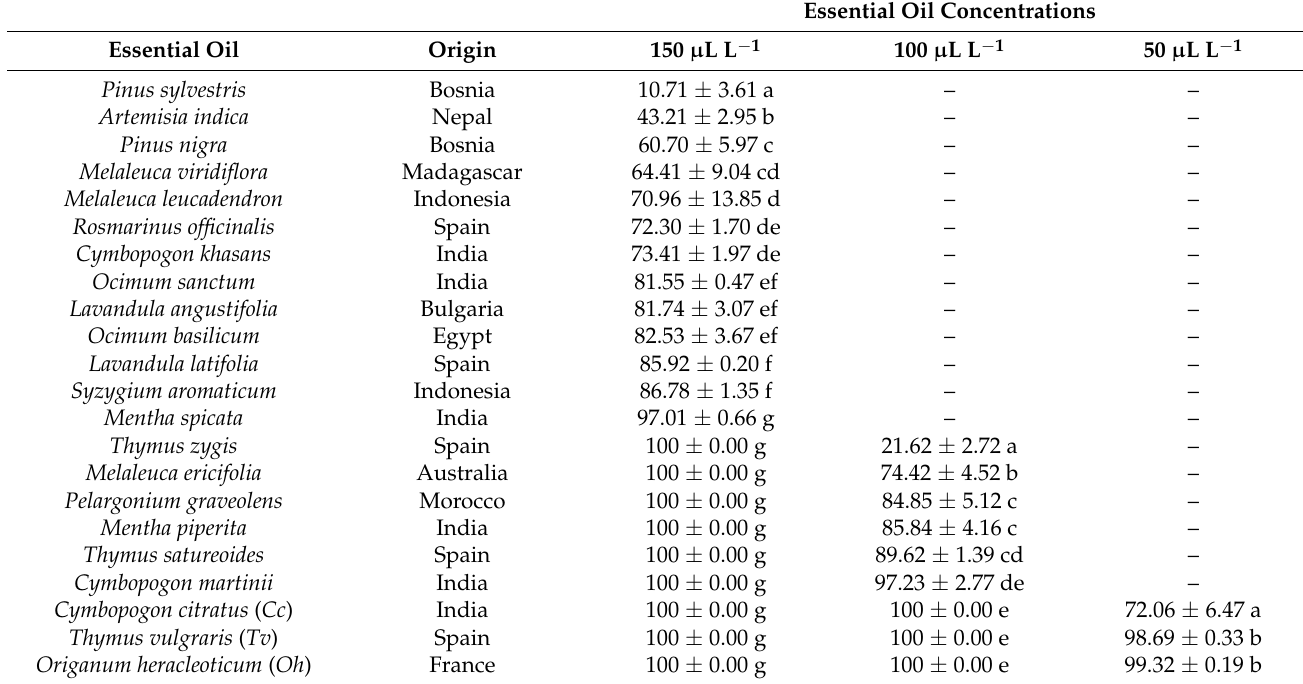
Table 1. Percent inhibition of mycelial growth of Botrytis cinerea by essential oil